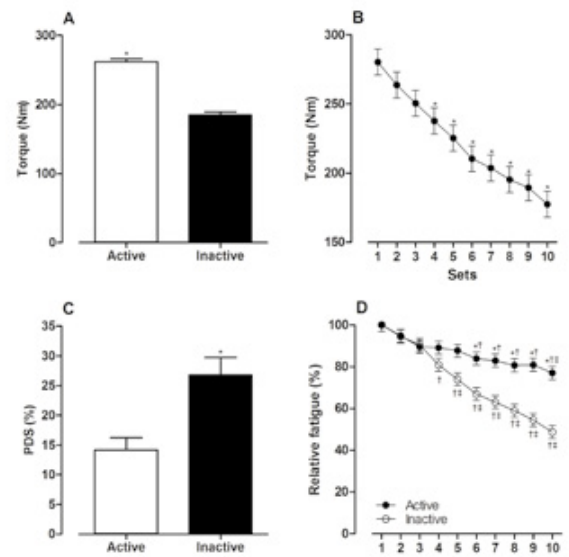
Figure 1. Values expressed in mean ± standard deviation of concentric torque mean and standard deviation corresponding to the first sets between active and inactive groups (A) between sets of 10 repetitions, (B) of the knee extension isokinetic exercise, percentage decrement score and torque concentrics (C) mean and standard error related to do the first set (D) performed by the active and inactive groups, and between sets of 10 repetitions of the knee extension isokinetic